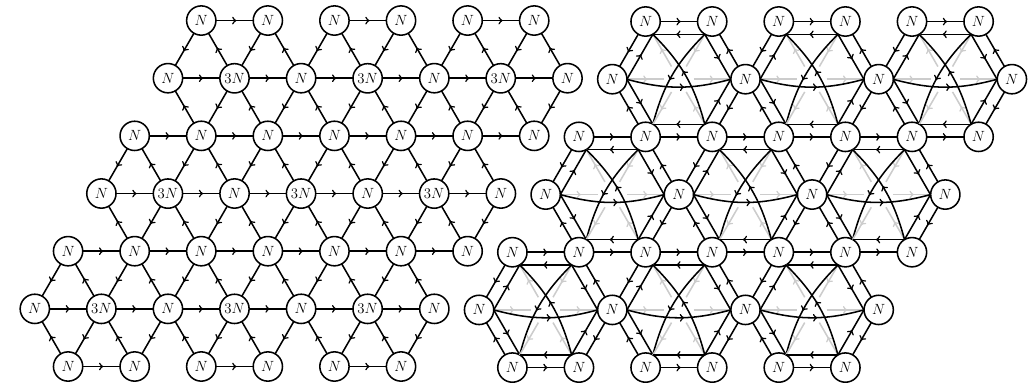
Figure 2 . Left: the moose diagram for the (SU(3 N ) × SU( N ) 3 ) k triangular theory, in the regime where the gauged SU(3 N ) are weakly coupled. The SU( N ) nodes on the boundary of each figure (with nonzero cubic ‘t Hooft anomaly coefficients) are global symmetries. Each triangular plaquette can be encircled by gauge-invariant trace operators of the form W ∼ λ Tr ( Q 1 Q 2 Q 3 ) , where Q 1 ... 3 are the three bifundamental quarks that lie on the edges of the plaquette. Right: the moose diagram of the SU(3 N ) invariant degrees of freedom, in the limit µ (cid:28) Λ 3 N . The paired bifundamental quarks at the edge of each hexagon acquire vectorlike mass terms of order O ( λ Λ 3 N ) from the trace terms in the superpotential, and are integrated out of the infrared